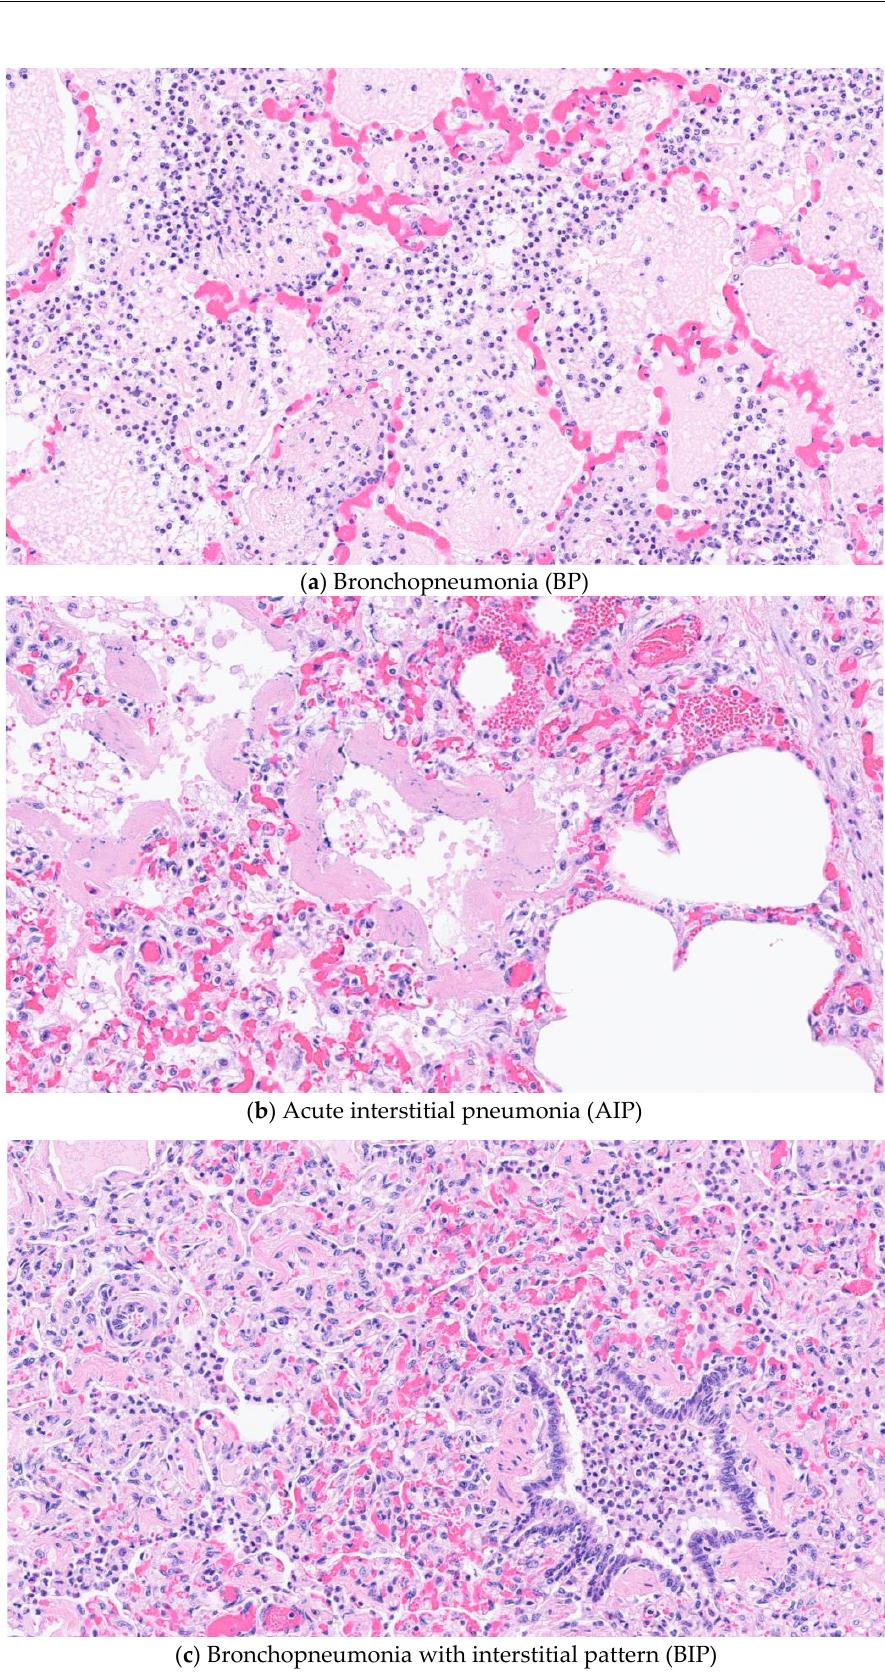
Figure 3. Photomicrograph examples from individual cases diagnosed with bronchopneumonia (BP) ( a ); acute interstitial pneumonia (AIP) ( b ); bronchopneumonia with interstitial pattern (BIP) ( c ).